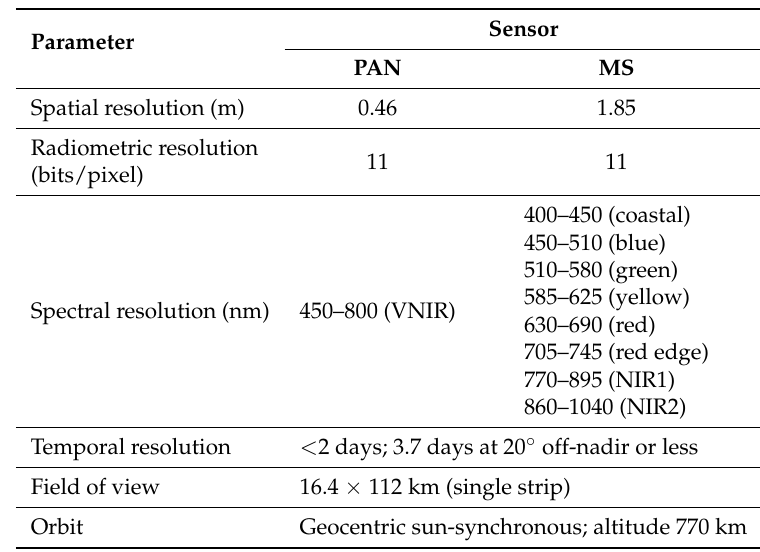
Table 1. Nominal characteristics of the Worldview-2